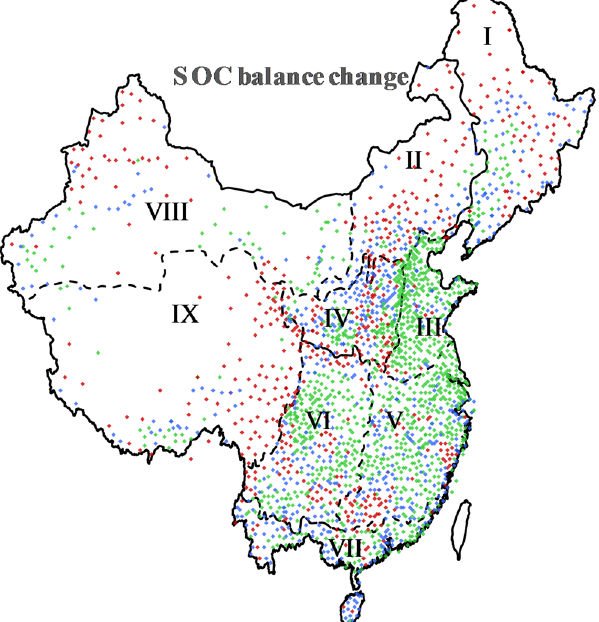
Figure 4. Type of turnover in SOC equilibrium state in all of the units in China. The turnover types were categorized based on the temporal trend of C balance on China’s cropland: healthy (was a sink or neutral in the 1980s and a sink in the 1990s), recovering (was a source or neutral in the 1980s and neutral in the 1990s), and degenerated (changed from a sink in the 1980s to neutral in the 1990s or was a source in both the 1980s and 1990s). The figure was generated using Microsoft excel 2016 software provided by Microsoft